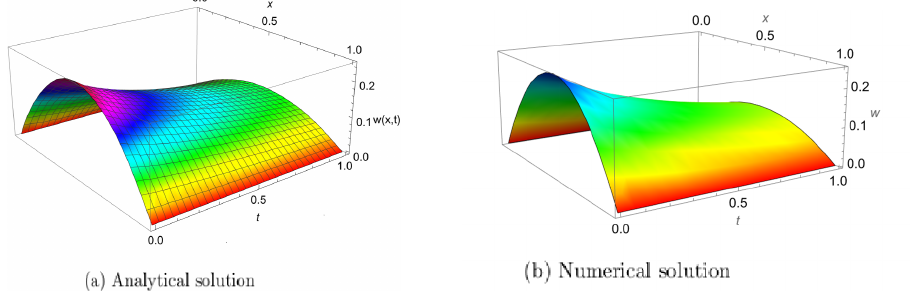
Figure 2. The analytical and numerical solution of (36) for α = 0.5, β = 1.9 and T = 1.